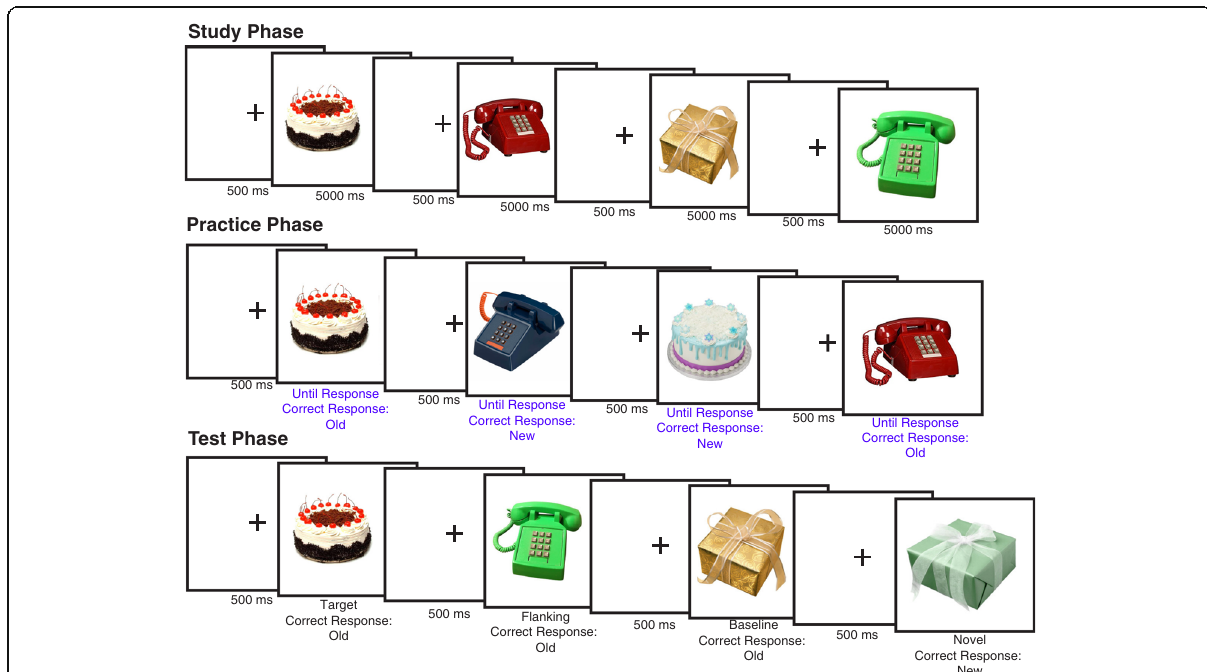
Fig. 1 The general methods for all three experiments. In the study phase, subjects fixated a central fixation point for 500 ms, followed by the presentation of the stimuli for 5000 ms, until all stimuli were presented. The subjects were instructed to remember each item for a later memory test. The study phase was followed by a 5-min visual distractor task. In the practice phase, half of the items from half of the categories were again presented along with an equal number of novel items. Subjects engaged in recognition practice by completing an old – -new recognition judgment task in response to each item. Each old item was practiced on two practice trials. The practice lures were items drawn from the same categories as the practice items. The second phase was followed by another 5-min visual distractor task. The test phase employed the same old – new recognition judgment task as the second phase, but included 36 old stimuli from the study phase (12 baseline, 12 practiced, and 12 related), as well as an equal number of novel test lures from the same categories. Hit rates from this test phase are presented in Figs. 2, 3 and